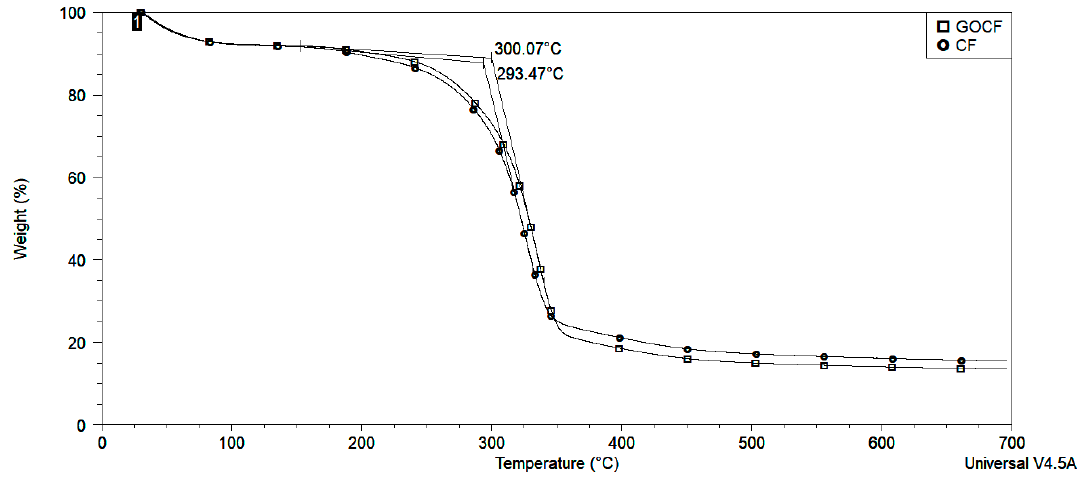
Figure 6. Thermogravimetry analysis (TGA) curves of CF and GOCF fibers.